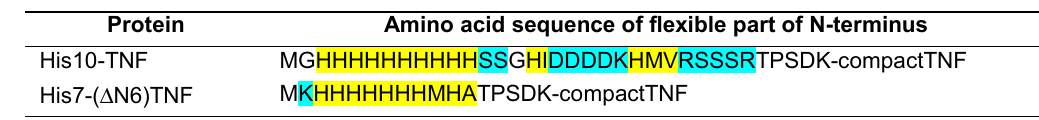
Composition and Polarity/Hydrophobicity of the N-Terminal Parts of His10-TNF